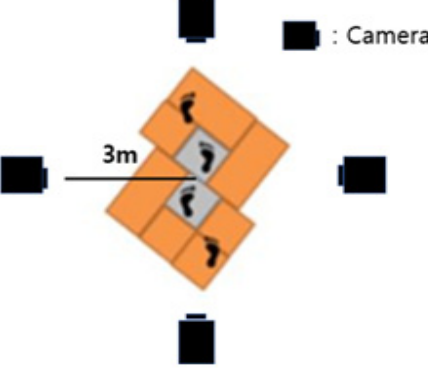
Figure 1. Experimental environment.